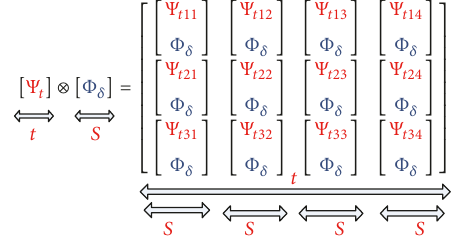
Figure 3: The diagram of the joint measurement matrix in